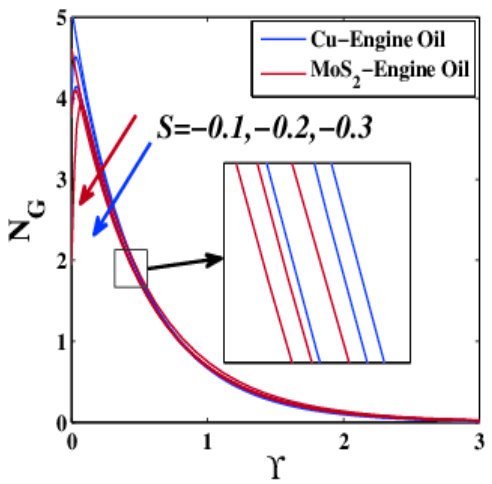
Figure 29. Entropy variation 𝑁 (cid:3008) under the influence of 𝑆 < 0 .